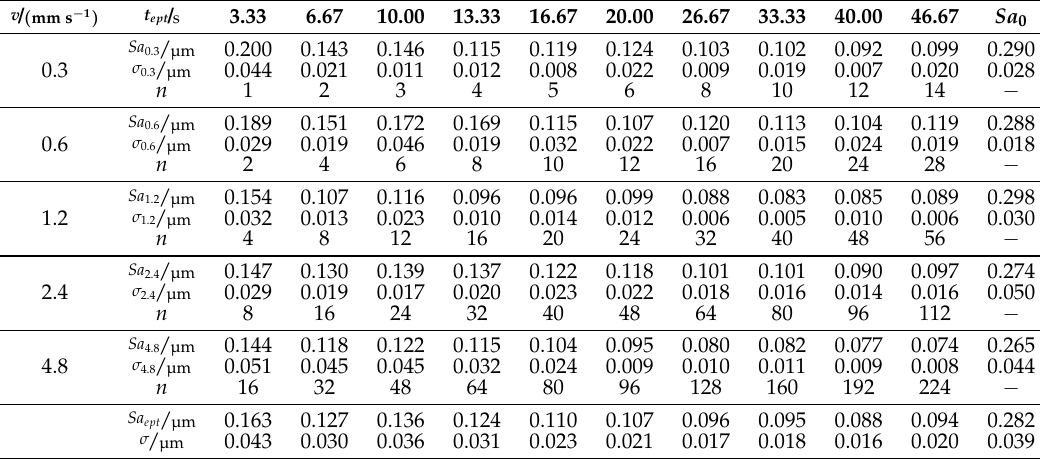
Table 2. Average surface roughnesses Sa v of the weld seam depending on the selected velocity v and number n of plasma polishing passages. The results are listed in columns for a sequence of effective polishing times t ept . The initial average surface roughness Sa 0 is given in the last column. The last row presents the mean value Sa ept of all above listed values Sa v for the particular effective polishing times t ept